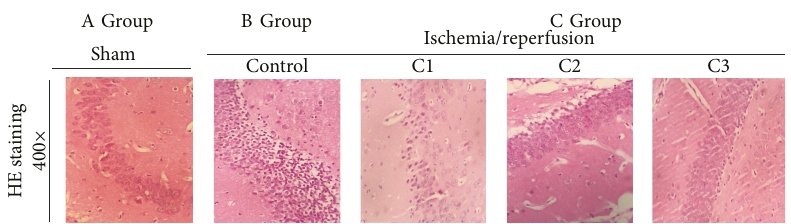
Figure 3: Alteration in the neurocyte morphology of CIRI mice. Stained with HE. Magni fi cation: × 400; HE: hematoxylin and eosin; group A: sham-operated; group B: control; group C1: pretreatment; group C2: treatment; group C3: pretreatment+ treatment.